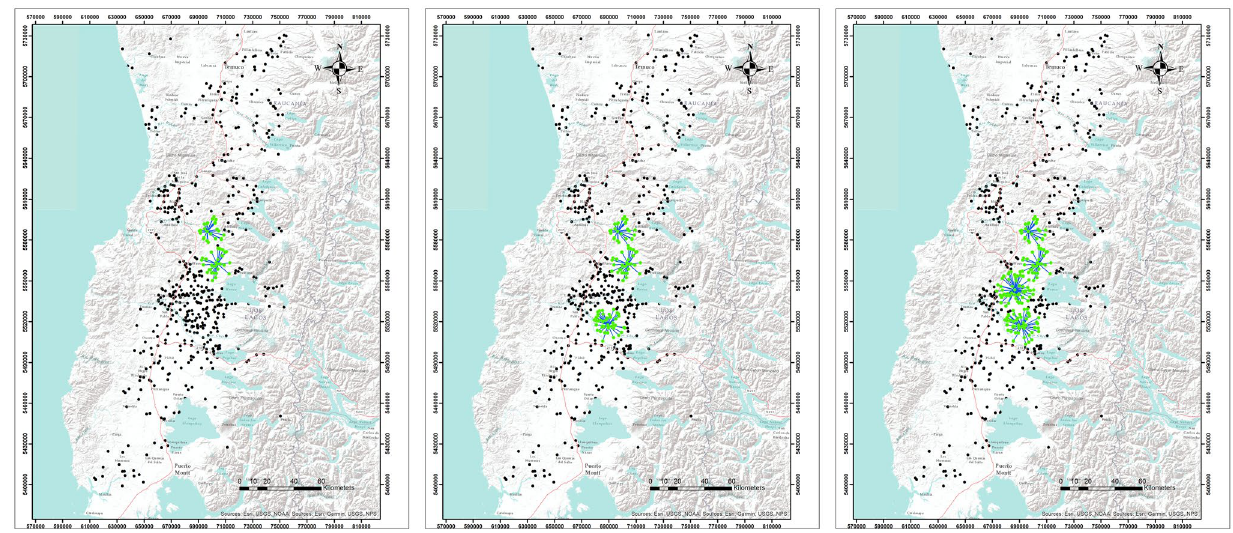
Fig. 12 Location of the configurations of the best combination found, with 60% biomass availability scenario, transport cost of 0.4 USD/tkm, and energy price of 96, 98 and 100 USD/MWh, in order of